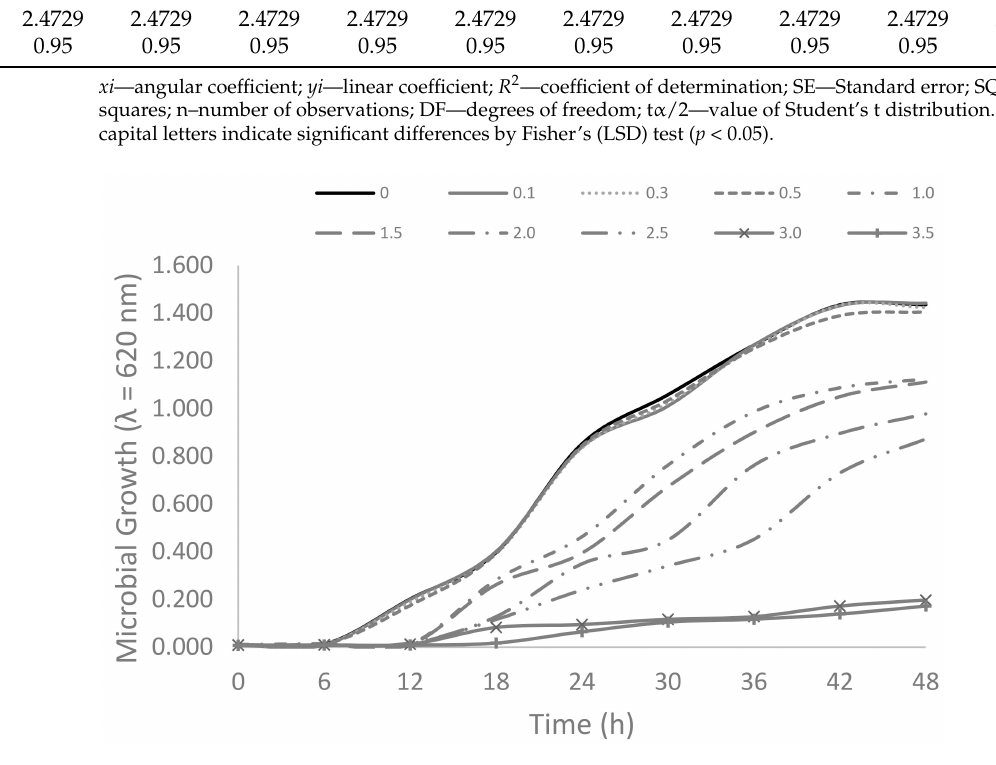
Figure 2. In vitro efficacy of PPCP against the growth of natural microbiota in vacuum-packaged cooked sausages. The inoculum was adjusted to ca. 5.5 log cfu/g before testing, and the turbidity method was used to evaluate the